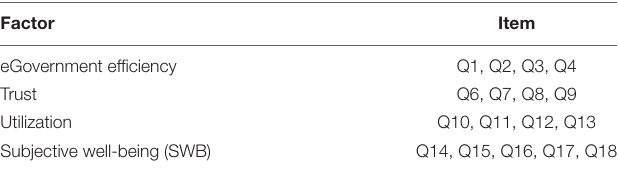
TABLE 4 | Results of factor analysis.